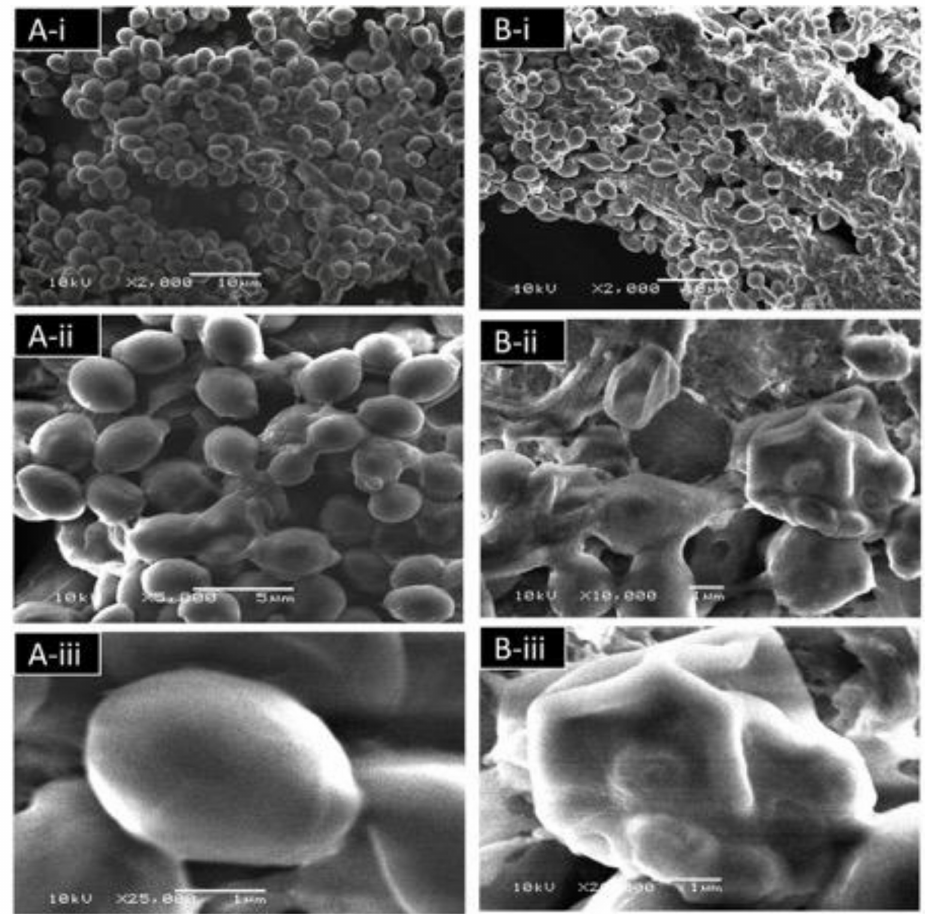
Figure 8. ( A ) Scanning electron micrographs showing C. albicans biofilm after 24 h without treatment at ( i ) 2000 × , ( ii ) 5000 × , and ( iii ) 25,000 × . ( B ) Scanning electron micrographs showing effects on C. albicans biofilm after 24 h treatment with TEO at ( i ) 2000 × ( ii ) 10,000 × , and ( iii ) 25,000 ×